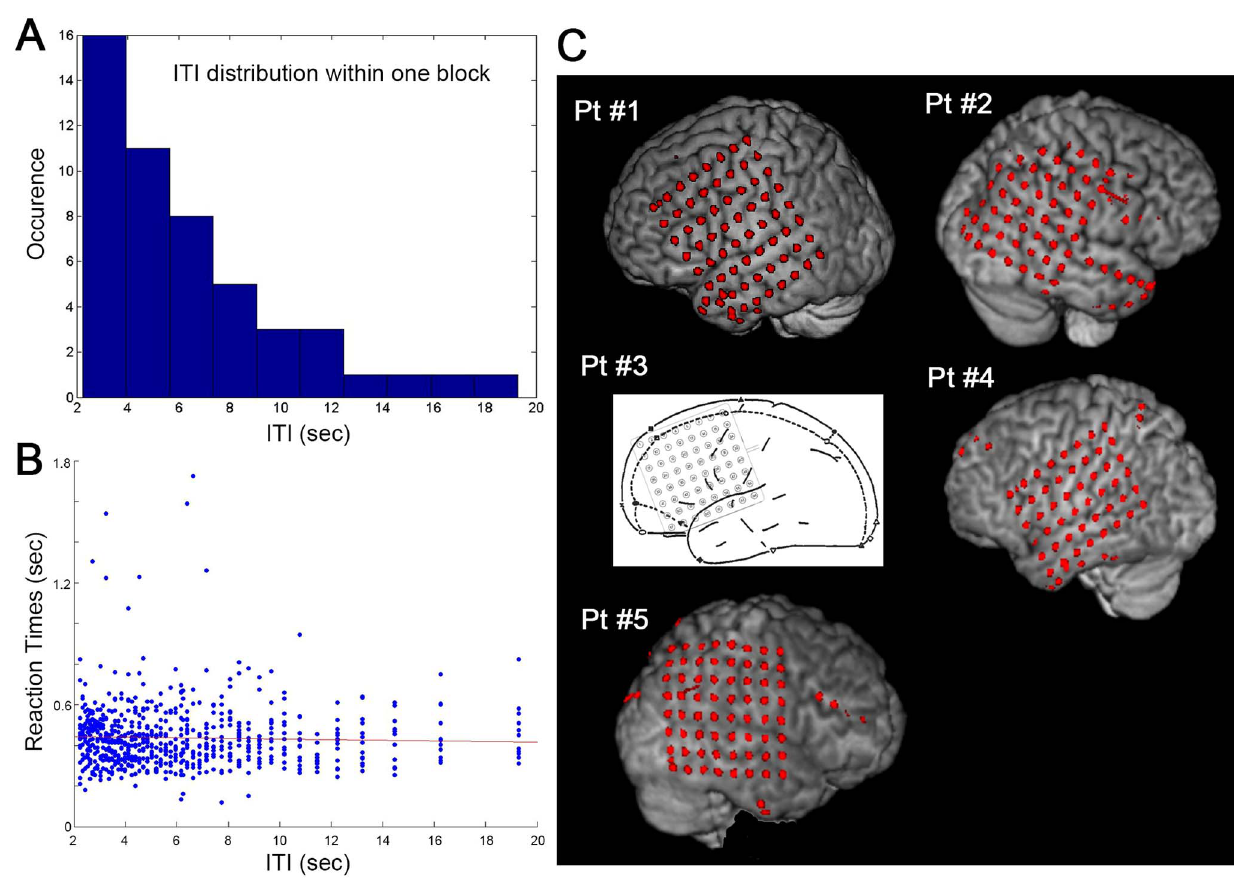
Figure 1. Task design, behavioral data and electrode coverage. ( A ) The distribution of inter-trial intervals (ITIs) in one task block containing 50 trials. This distribution is identical across blocks. ( B ) A scatter plot of reaction times (RT) against ITI across all hit trials in all subjects over contralateral blocks. There was no dependence of RT on ITI (P . 0.1, Spearman rank correlation). The red line indicates the best linear regression fit. ( C ) Electrode locations in each subject overlaid on the pial surface reconstructed from the subject’s own anatomical MRI. All intracranial electrodes are shown, including electrodes excluded due to signal quality issues or from the Laplacian montage derivation (those on the electrode strips or on the edge of the grid). For Pt # 3, the clinical CT scan was not acquired, thus electrode locations could not be determined in relation to the MRI and the presurgical planning diagram is shown instead.